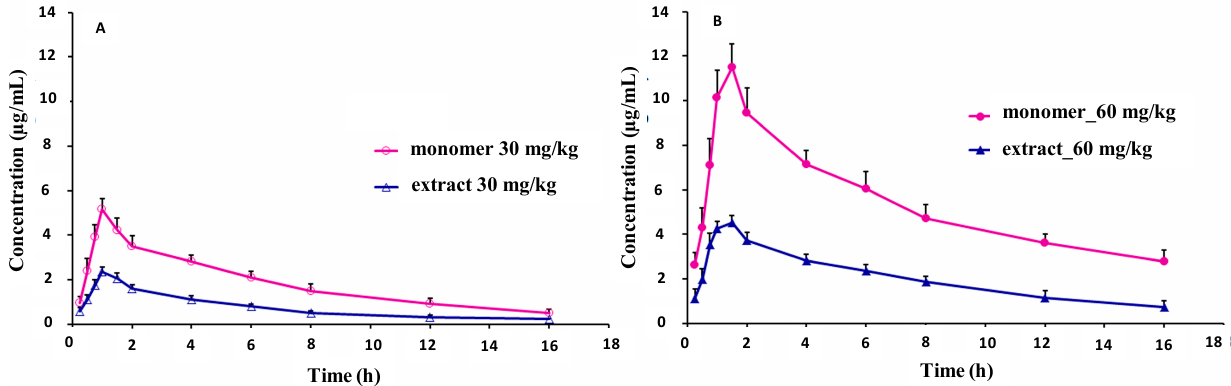
Figure 3. Representative curves of sinomenine concentrations versus time profiles in rat plasma after oral administration of sinomenine monomer ( ○,●), and the Sinomenium acutum extract ( ,▲). ( A ) plot for 30 mg/kg sinomenine monomer and Sinomenium acutum extract; ( B ) plot for 60 mg/kg sinomenine monomer and Sinomenium acutum △